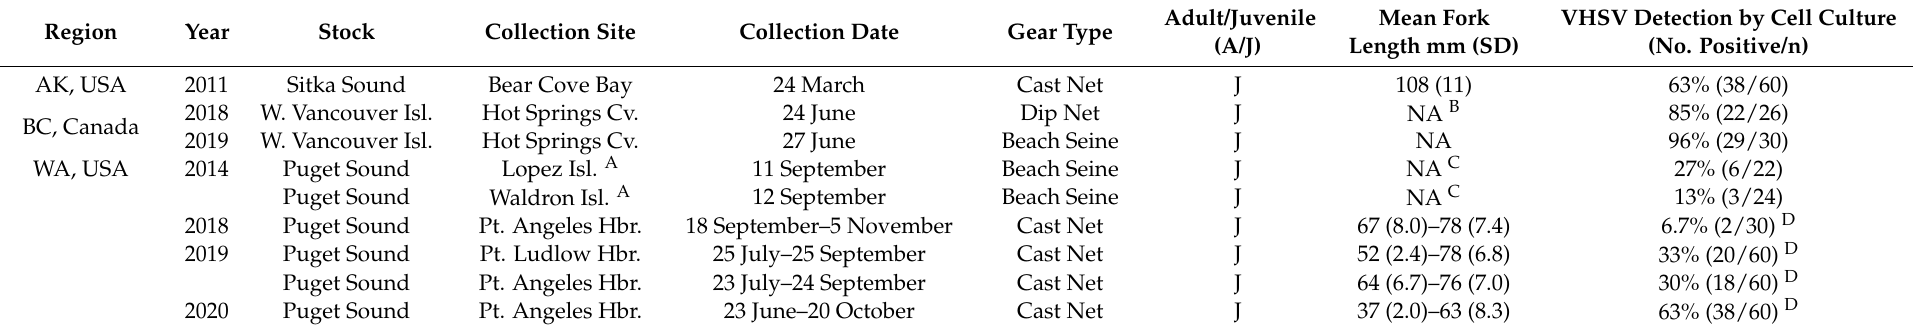
Table 2. Viral hemorrhagic septicemia virus (VHSV) survey results from Pacific herring C. pallasii during epizootic